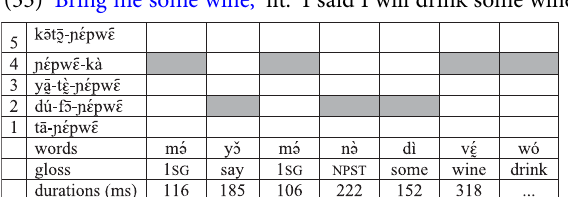
Other idioms include phrases for asking people to come, as well as ways of addressing different types of people. There are speci fi c phrases used when addressing balafon griots, drum griots and